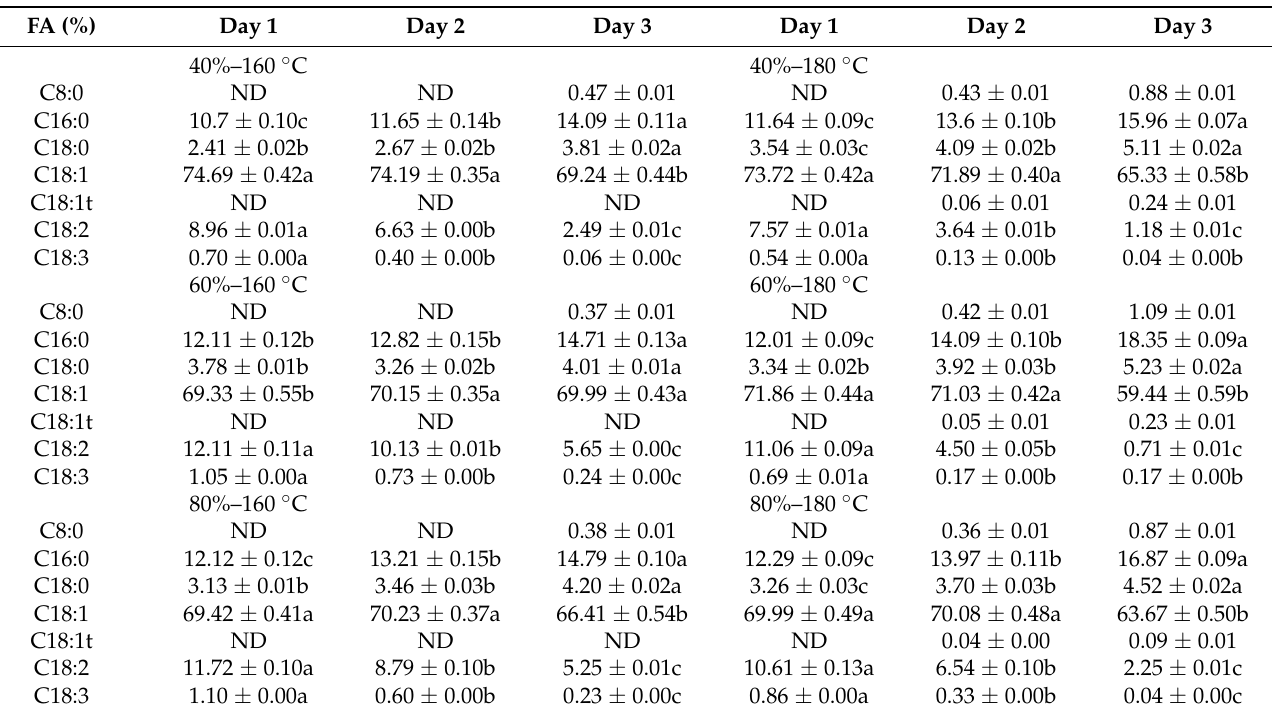
Figure 2. AV ( A ) and POV ( B ) of the 40, 60 and 80% olive-based DAG oil after 3 days of frying. During frying, the fatty acid composition changed significantly (Table 2). With the continuous heating, palmitic acid (C16:0) increased, and the content of oleic acid (C18:1), linoleic acid (C18:2) and linolenic acid (C18:3) decreased. Interestingly, C18:1t was detected after frying at 180 ◦ C for 2 days, mainly because C18:1 was the most abundant unsaturated acid in the oils. In addition, C8:0 was detected on the third day at 160 ◦ C and the second day at 180 ◦ C. Table 2. Changes in fatty acid composition of the 40, 60 and 80% olive-based DAG oil after frying for 3